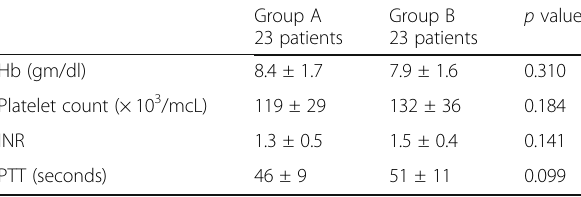
Table 2 Postoperative